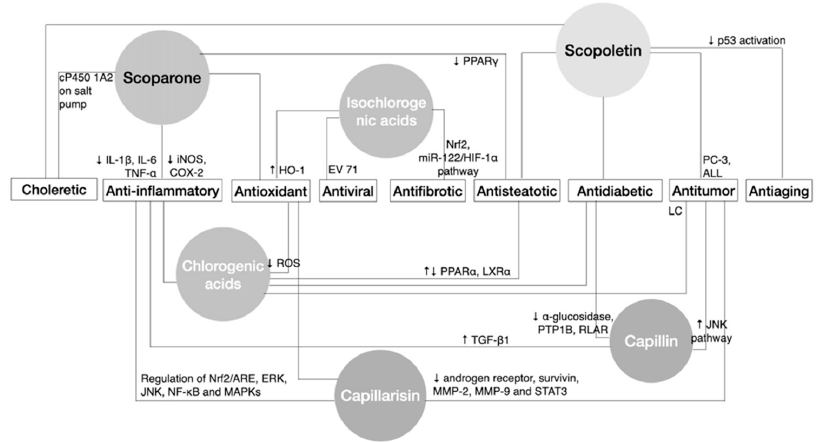
Figure 2. Schematic illustration of the bioactive components of Artemisia capillaris contributing to its therapeutic effects. Bioactive compounds include scoparone, scopoletin, capillarisin, capillin, chlorogenic acid, and isochlorogenic acid, which induce pharmacological effects of A. capillaris in a synergistic manner. PC-3: prostate cancer cells; ALL: acute lymphoblastic leukemia cells; LC: lung cancer cells; ↓ decrease or inhibit effects; ↑ increase or enhance effects; ↓↑ modulate effects.